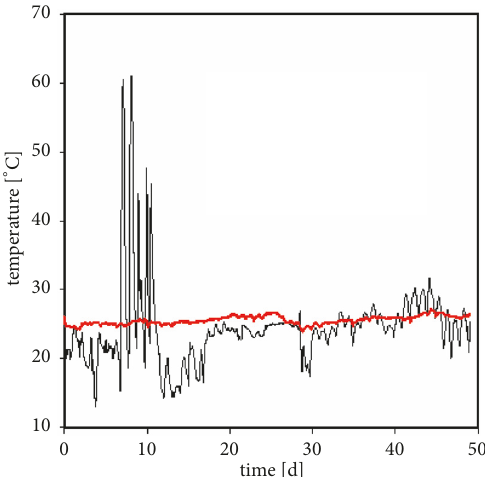
Figure 3: Temperature course for the stored samples (red line) and the mailed samples (black